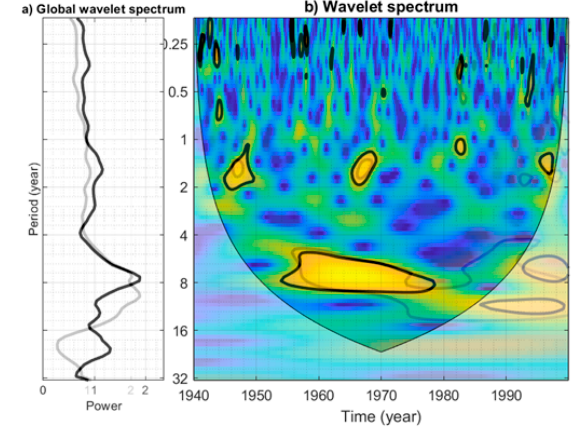
Figure 8. Graph overlay of ( a ) Global wavelet spectrum and ( b ) wavelet spectrum of the regionalized monthly rainfall over the Congo river basin (from CRU (dark line) and SIEREMv1 gridded rainfall) (gray line) (1940–1999).